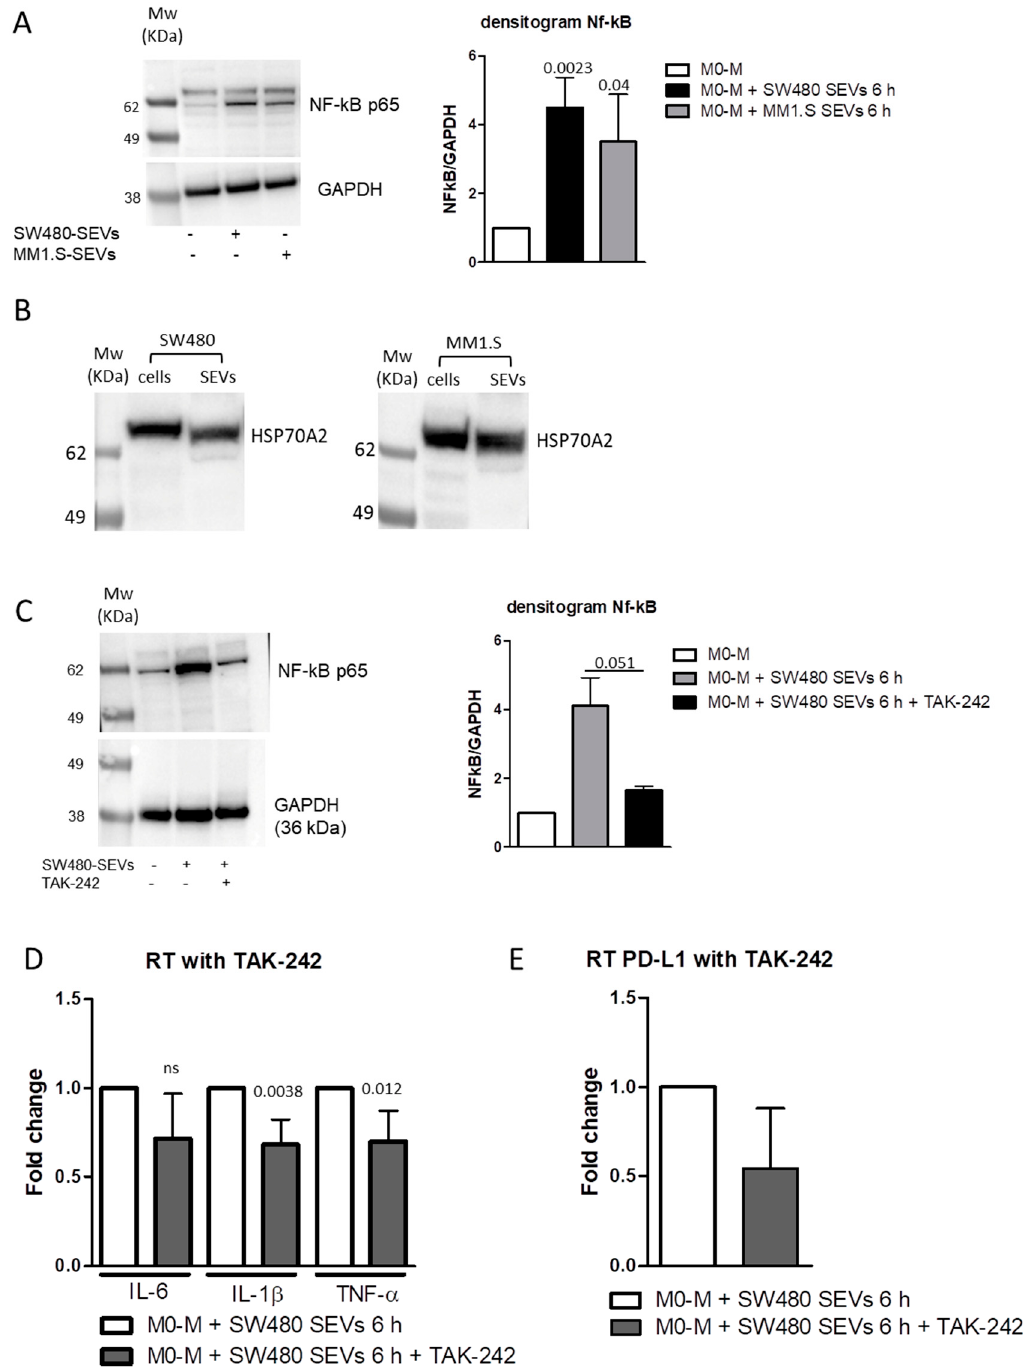
Figure 4. ( A , left panel) Western Blot analysis of NF- κ B and β -actin proteins in M0-M treated with MM1.S- and SW480- SEVs for 6 h. ( A , right panel) Densitometric analysis of Western Blot. The reported values are the mean ± standard deviation of two replicates. ( B ) Western Blot analysis of HSP70A2 in MM1.S and SW480 cell lysates and derived SEVs. ( C , left panel) Western Blot analysis of NF- κ B and β -actin proteins in M0-M treated with SW480-SEVs and TAK-242 for 6 h. ( C , right panel) Densitometric analysis of Western Blot. The reported values are the mean ± standard deviation of two replicates. ( D ) RT PCR of IL-6, IL-1 β , and TNF- α mRNA levels in M0-M treated with SW480-SEVs and TAK-242 for 6 h. The reported values are the mean ± standard deviation of three replicates at least. ( E ) RT PCR of PD-L1 mRNA levels in M0-M treated with SW480-SEVs and TAK-242 for 6 h. The reported values are the mean ± standard deviation of three replicates. The statistical significance of the differences between the SEV-treated cells and SEV-treated cells plus the inhibitor was analyzed using a two-tailed Student’s t -test.